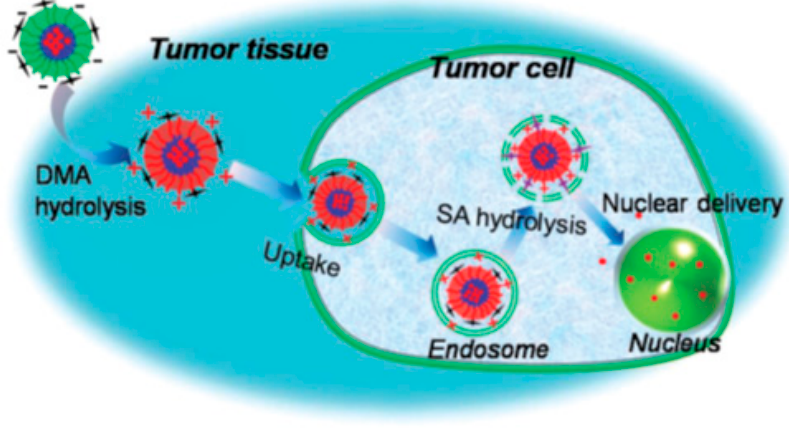
Figure 15. Mechanism for DOX delivery to tumors through nanoparticles [56].